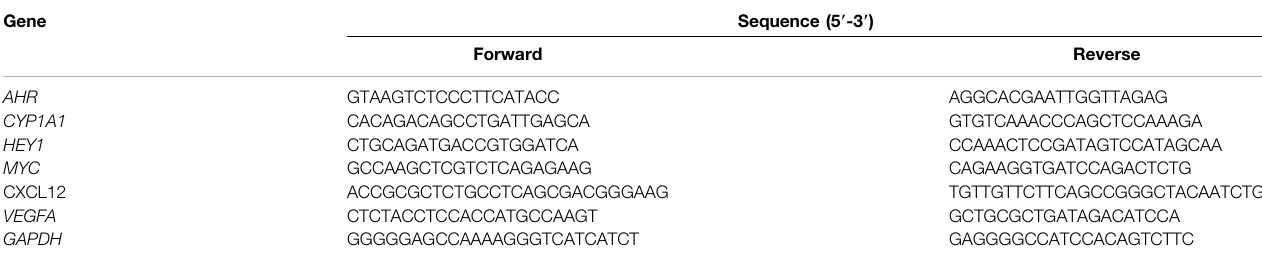
TABLE 1 | List of primers used in qRT-PCR